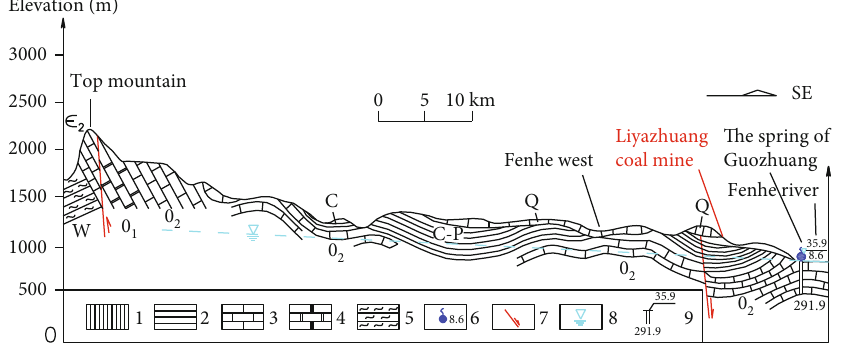
Figure 3: Hydrogeological pro fi le of the Guo Zhuang Spring